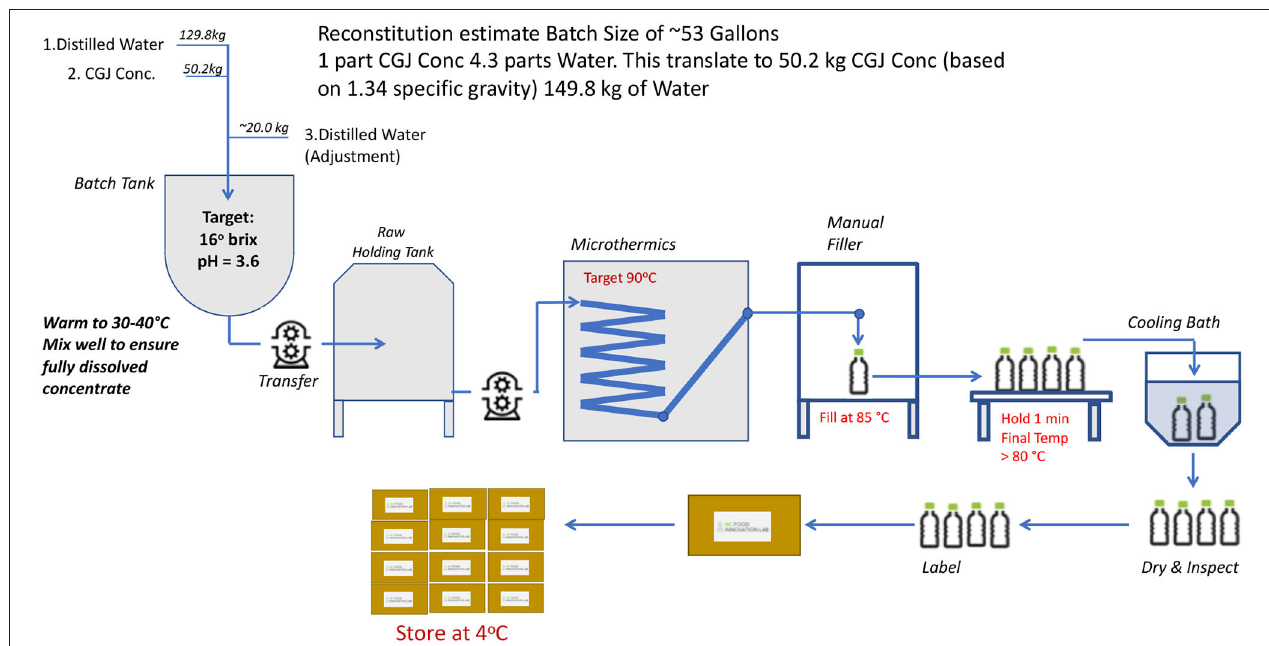
FIGURE 1 | Concord Grape Juice (CGJ) processing